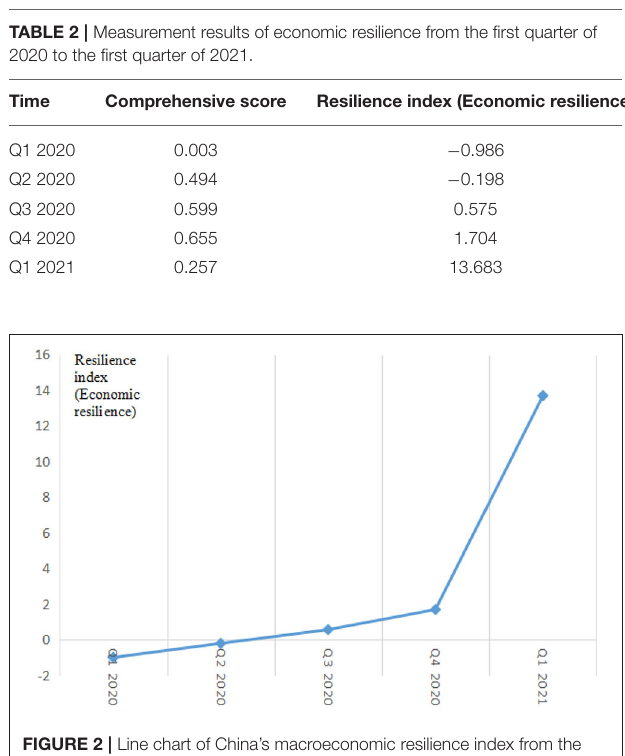
the epidemic is measured quarterly. The calculation results are shown in Table 2 .